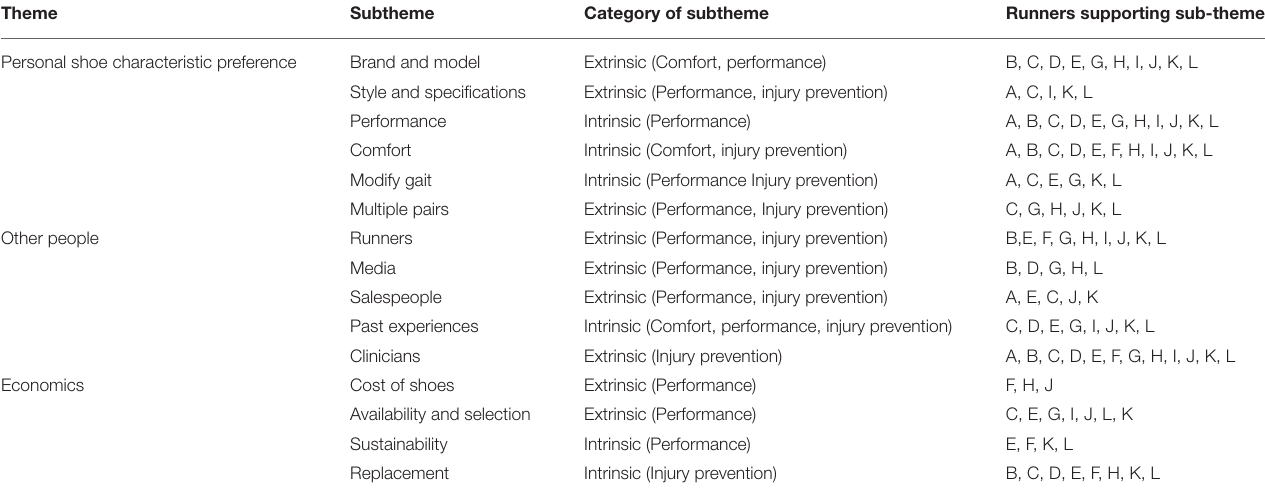
TABLE 2 | Summary of themes, subthemes and